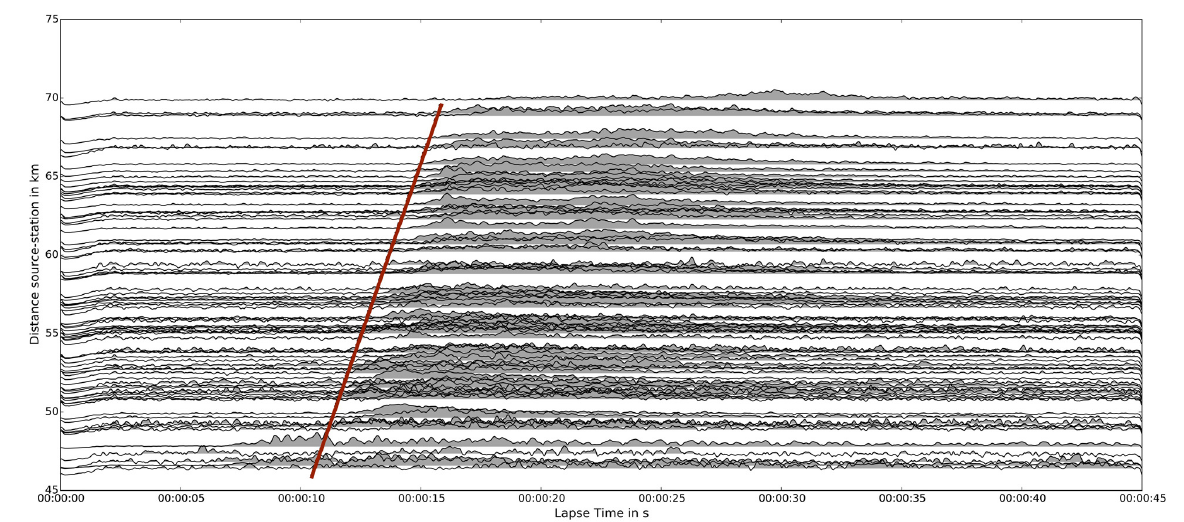
Figure 2. Sumtraces of envelopes over distance. Shown is the horizontal component (N-S) of station E078. The traces are normalized rela- tive to its respective maximum. The red line symbolize the onset of a P-wave with estimated velocity of v S-wave onset or